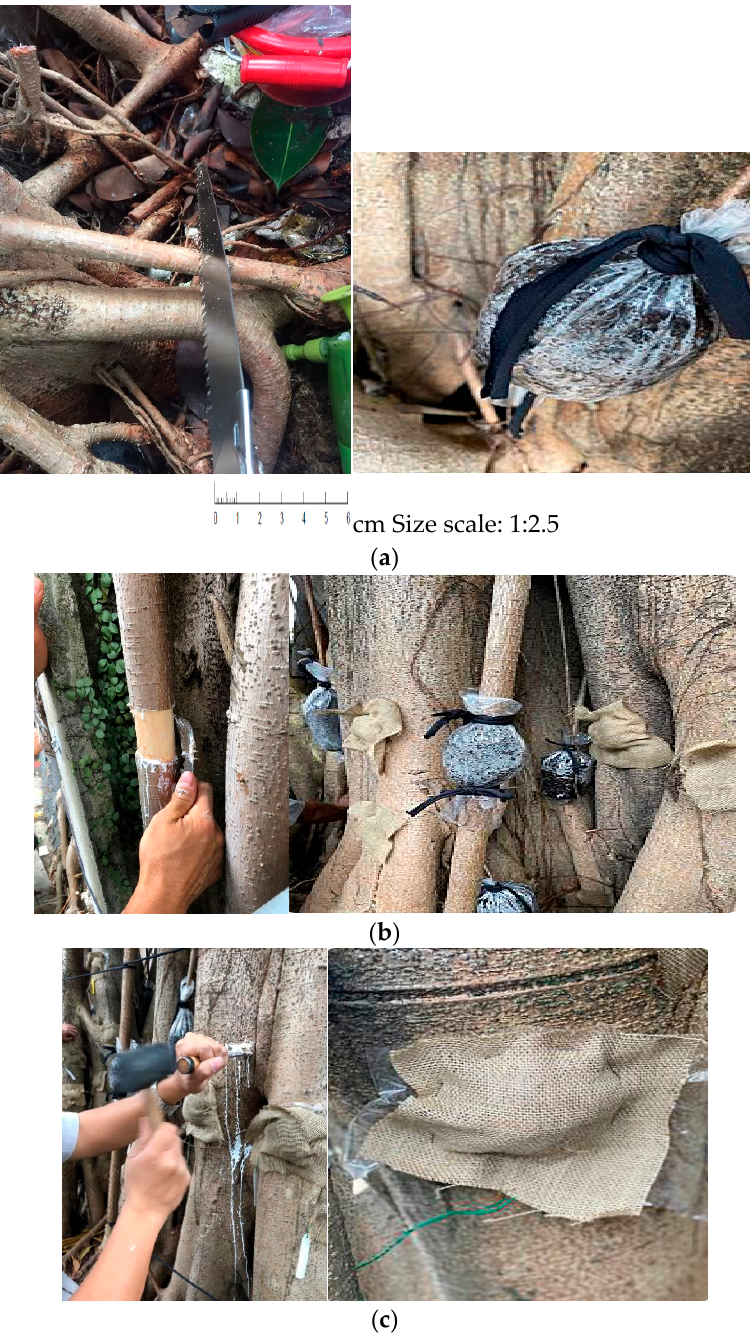
Figure 1. Wounding methods (WMs): ( a ) cutting off (CF), ( b ) girdling (GD), and ( c ) rectangular shape peeling (RP). ( a ) CF: cut off the aerial roots, ( b ) GD: girdle the aerial roots deep into the xylem, and ( c ) RP: incise a rectangular window on the surface of the prop roots of 4 × 2 cm deep into the xylem, then peel off the skin of the window.